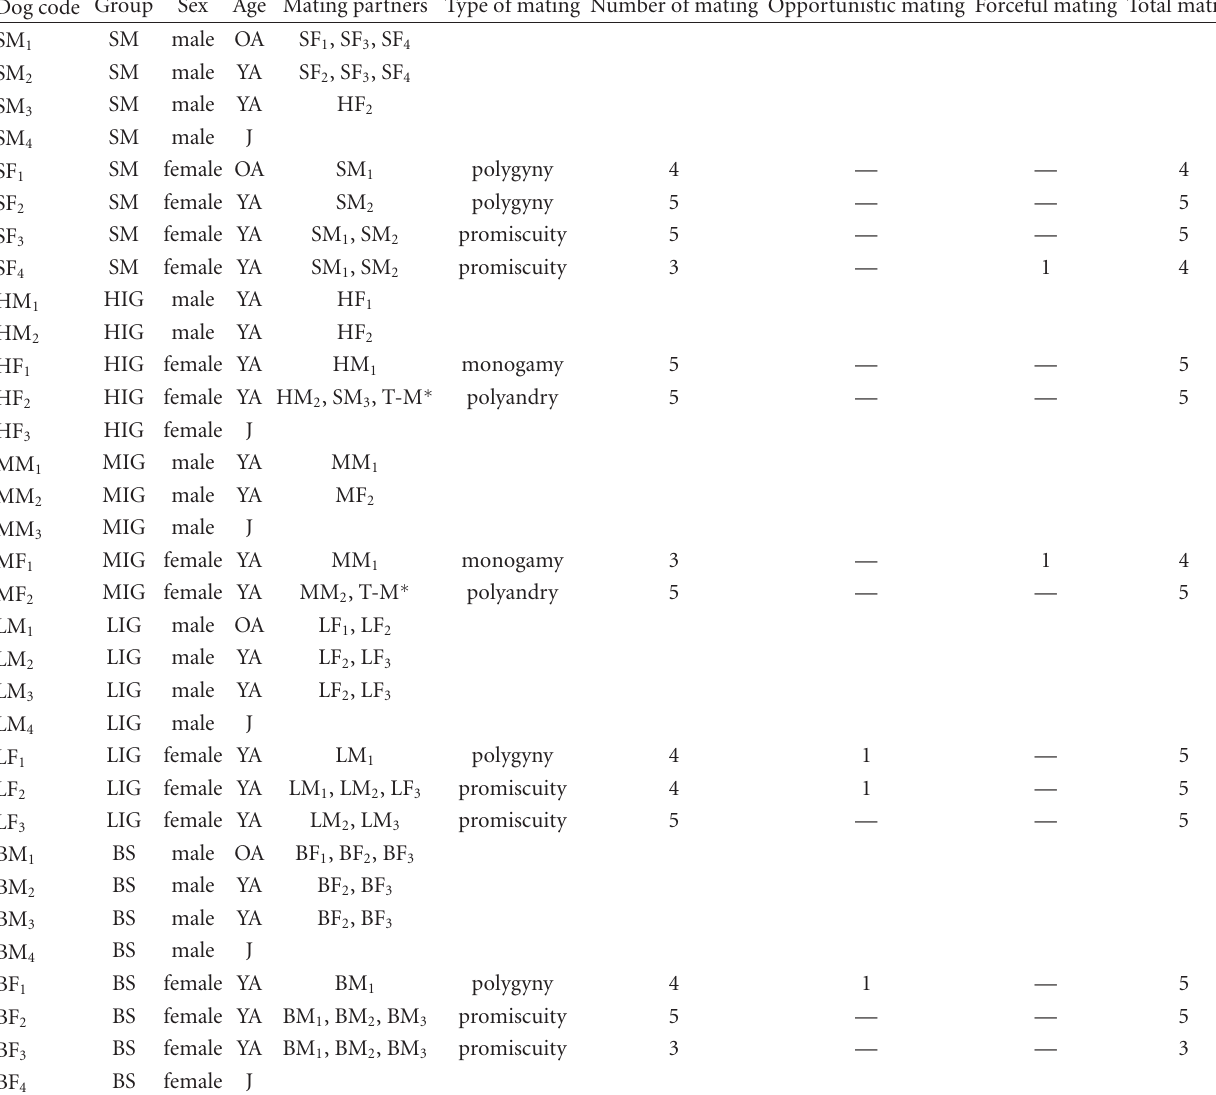
Table 1: Neighbouring dog groups with their mating history observed between 2008 and